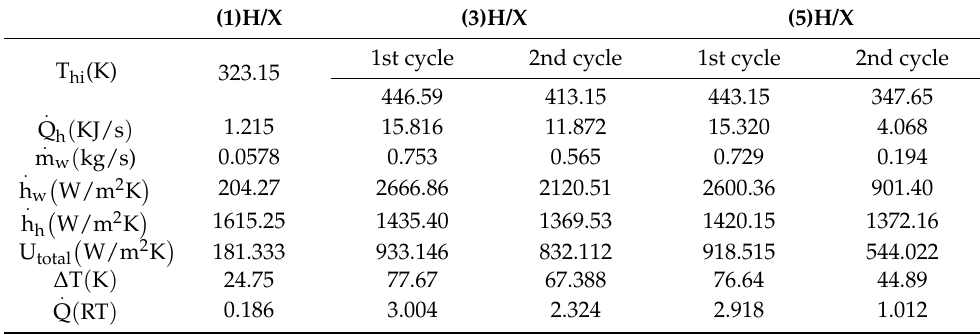
Table 8. Heat exchanger performance required in the first cycle and second